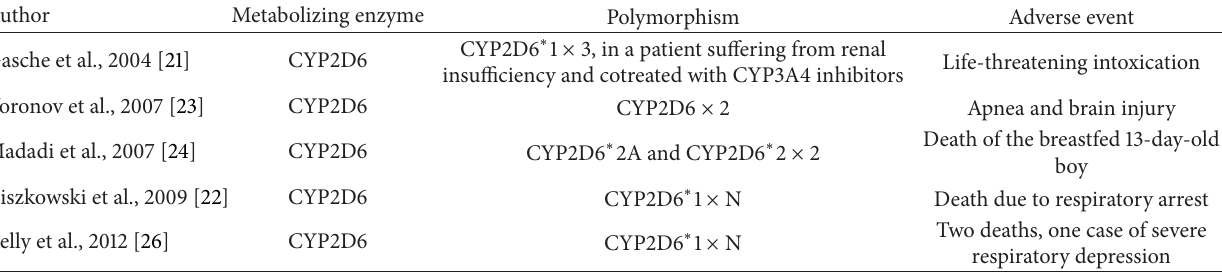
Table 1: Case reports providing evidence on the impact of polymorphisms of metabolizing enzymes on the safety of